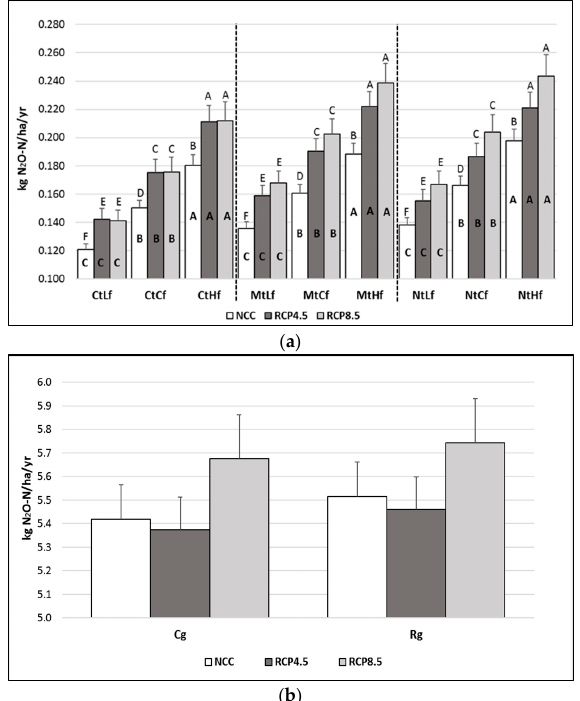
Figure 2. Denitrification–decomposition (DNDC)-modeled mean annual soil direct N 2 O fluxes ( ±se ) from 2019 to 2089, as a result of different ( a ) farm management policies under diverse climate scenarios and different ( b ) grazing systems under diverse climate scenarios. Cf = current fertilization (50 kg N ha − 1 yr − 1 ); Cg = continuous grazing; Ct = current tillage; Hf = higher fertilization rate ( + 50% Cf); Lf = lower fertilization rate ( − 50% Cf); Rg = rotational grazing; NCC = current climate;